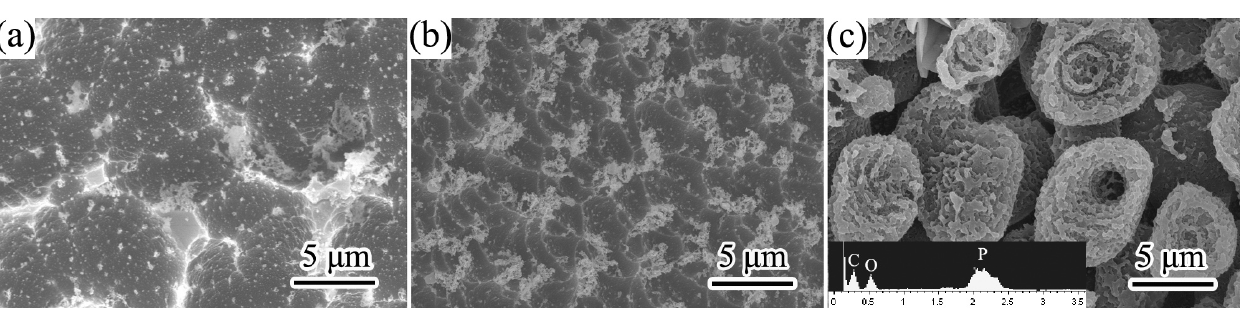
Figure 9. SEM images of based materials after AO erosion: ( a ) 6421resin, ( b ) PEK-C, ( c ) PS-100.